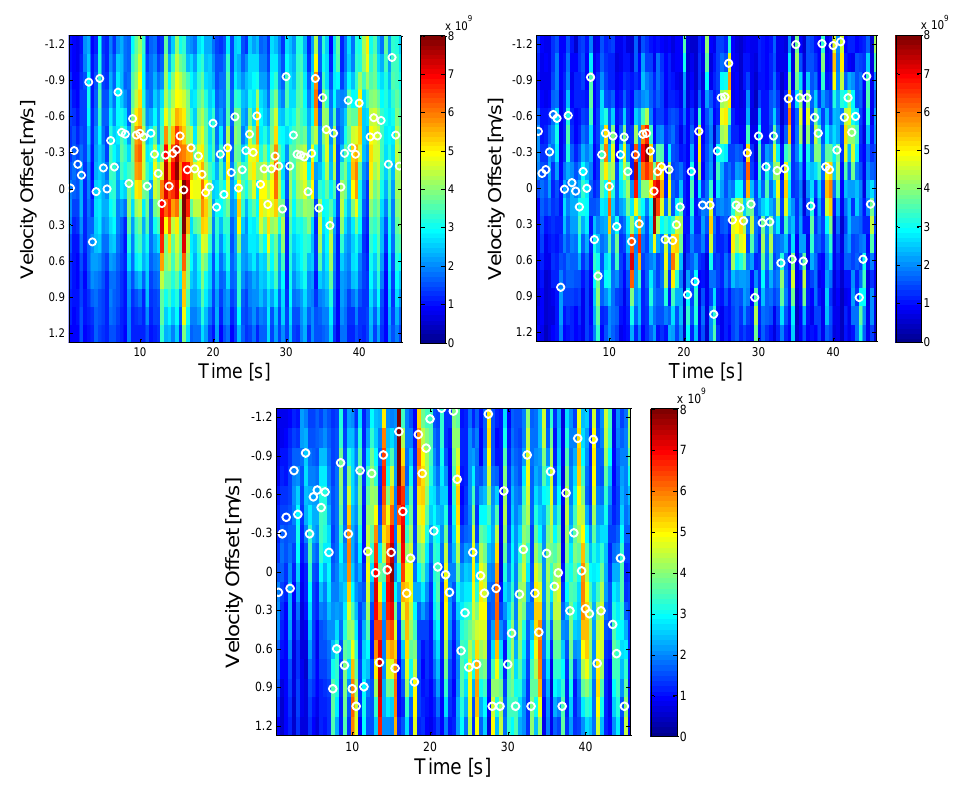
Figure 8. Power distributions in east, north and up velocity domains ( top left , top right and bottom )–Scenario